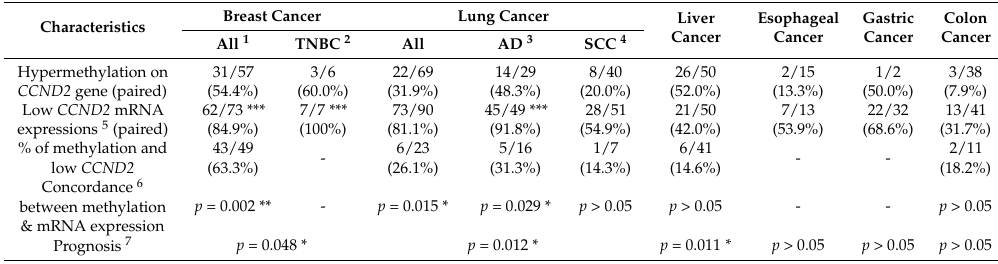
Table 1. The CCND2 methylation level and mRNA expression, and its effects on prognosis in cancers from TCGA.